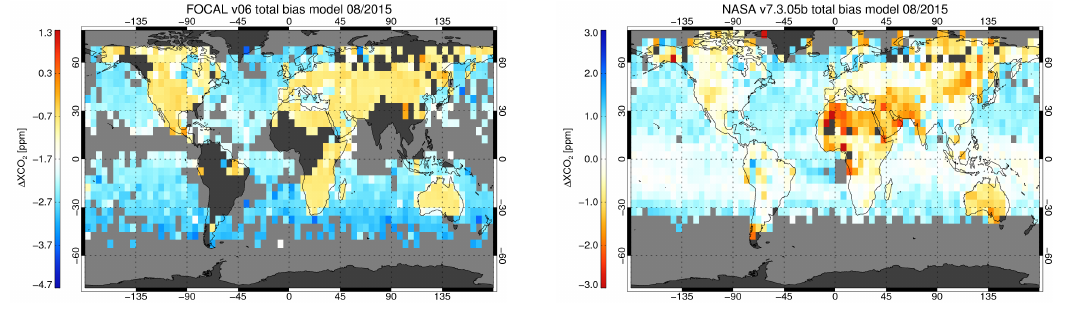
Figure 12. FOCALv06 total bias pattern (Equation (4)) at the example of August 2015 ( left ) and NASAOCO-2v7.3.05b total bias pattern ( right